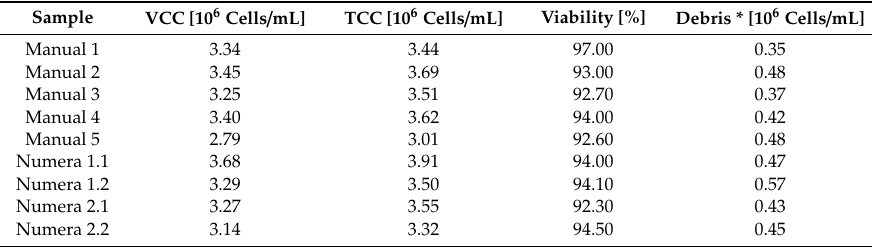
Table A1. The automated sampling system Numera, especially the dilution module, was roughly evaluated for its impact on cell integrity. CHO cells cultivated in shake flasks were directly analyzed with a cell counter (Cedex ® HiRes, Roche Diagnostics, Germany) 5-fold. The same cell suspension was then processed with the Numera system, i.e., drawn from the shake flask, transferred via multiplexer and dilution module, and manually captured after the dilution step. Subsequently, the samples were analyzed with the cell counter. The procedure with Numera was performed two times and each captured sample was analyzed in duplicate. The sample was analyzed for viable cell count (VCC), total cell count (TCC), viability, and cell debris. The results showed no noticeable impact of the Numera system on cell